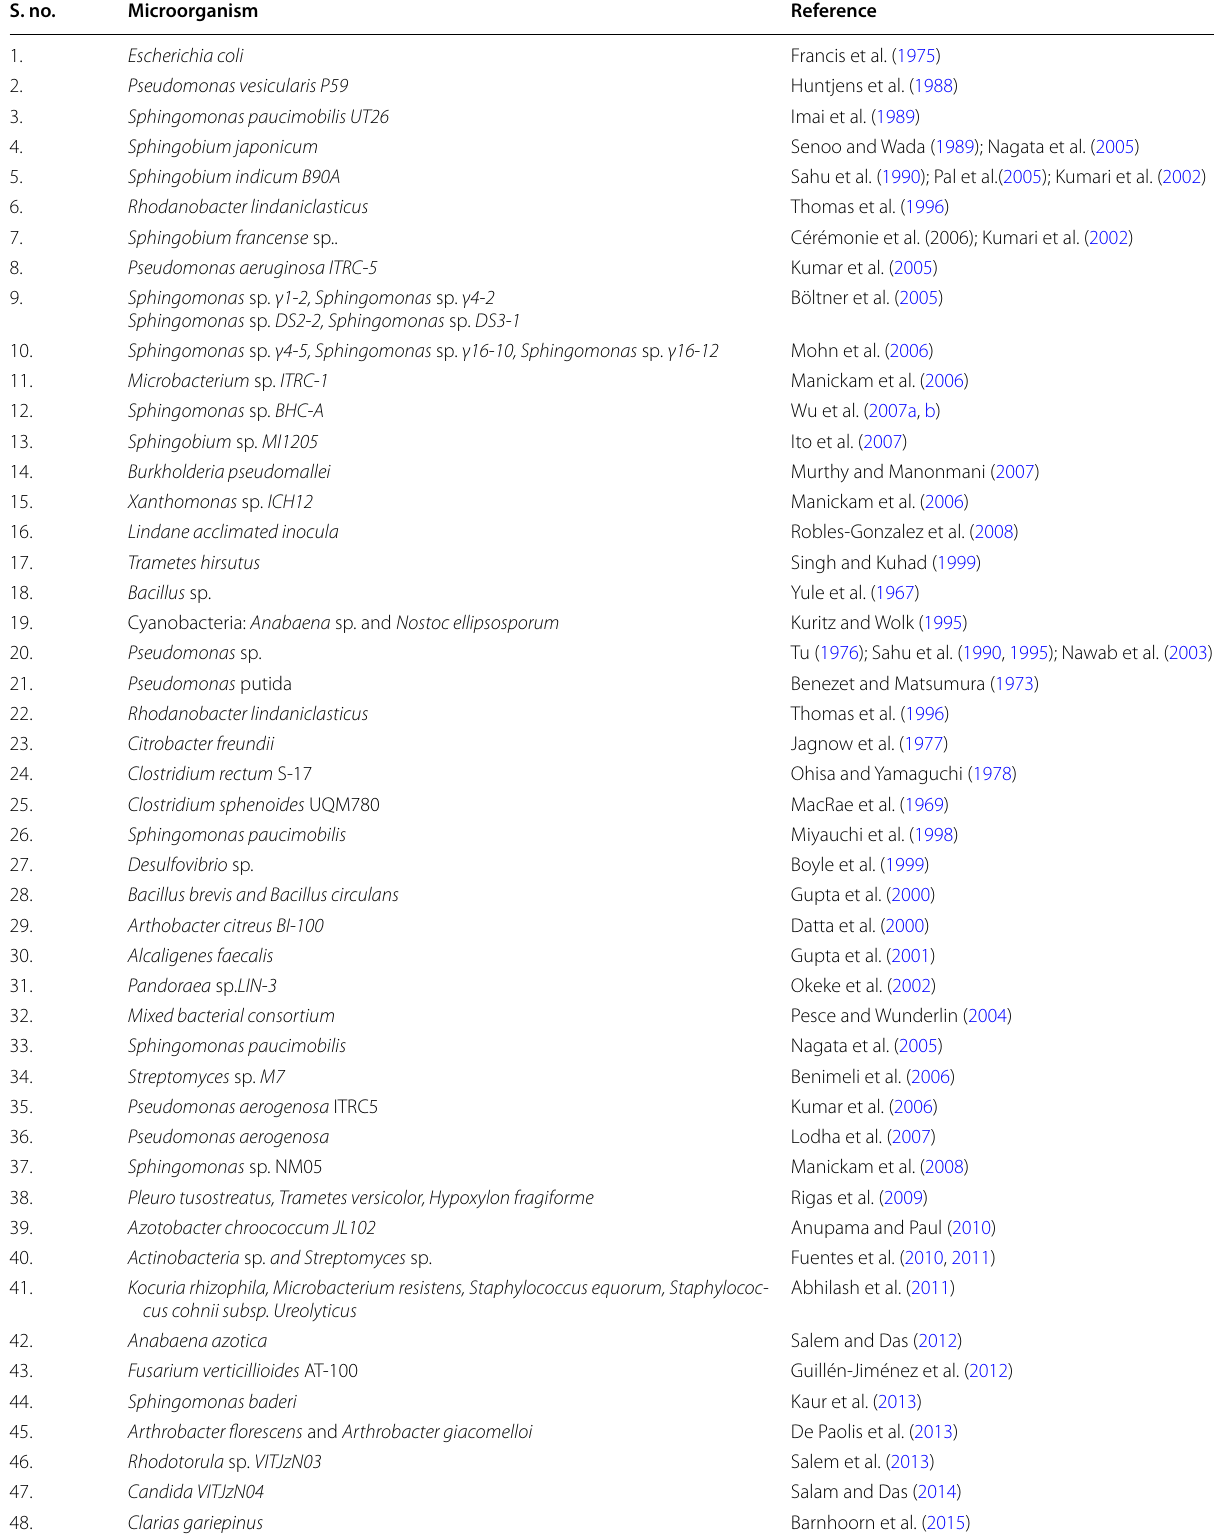
Table 1 List of lindane degrading microorganisms reported in different studies S.